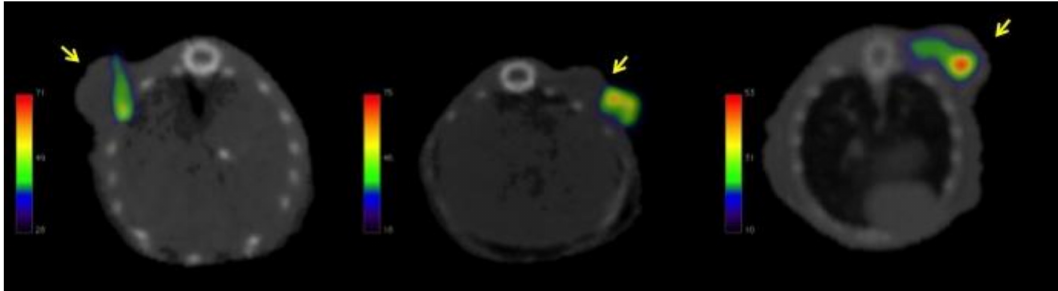
Figure 3. Representative transversal projection of each animal illustrating the tumor uptake of 67 Ga-nimotuzumab at 24 h post-injection. Arrows point to tumor location.